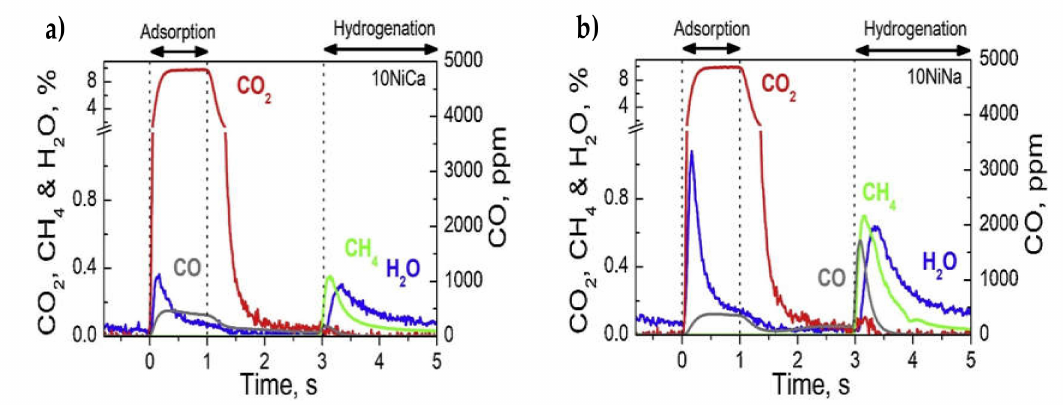
Figure12. CO 2 , H 2 O,CH 4 andCOconcentrationprofilesduringoneCO 2 adsorptionandhydrogenation cycle at 400 ◦ C with ( a ) 10NiCa and ( b ) 10NiNa catalysts. Reproduced with permission from ref. [112]. Copyright 2019